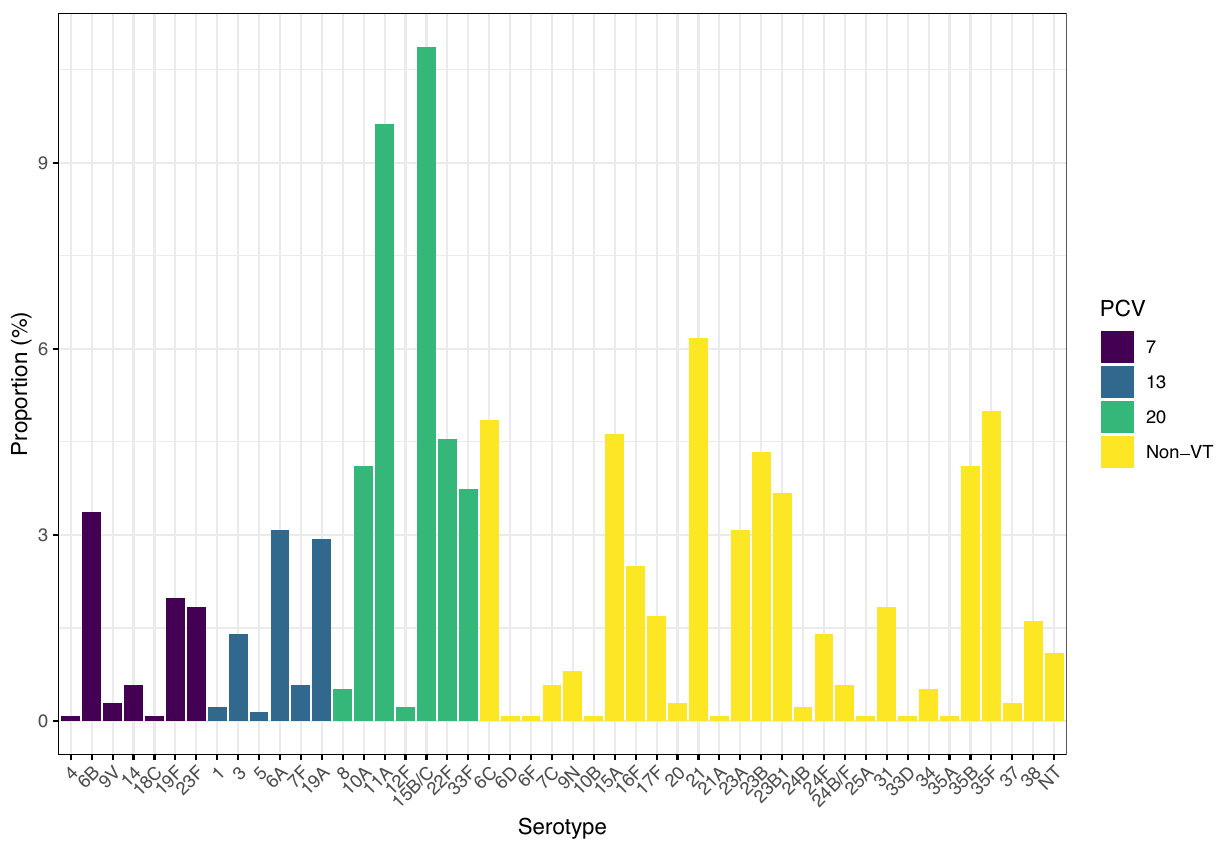
Figure 4. Serotype proportion for all S. pneumoniae isolated between 2006/07 and 2017/18. Serotypes are colored according to the PCV in which they are currently included (PCV13), previously included (PCV7) or included in newly licensed formulations (PCV20). Serotypes not in a PCV are shown in